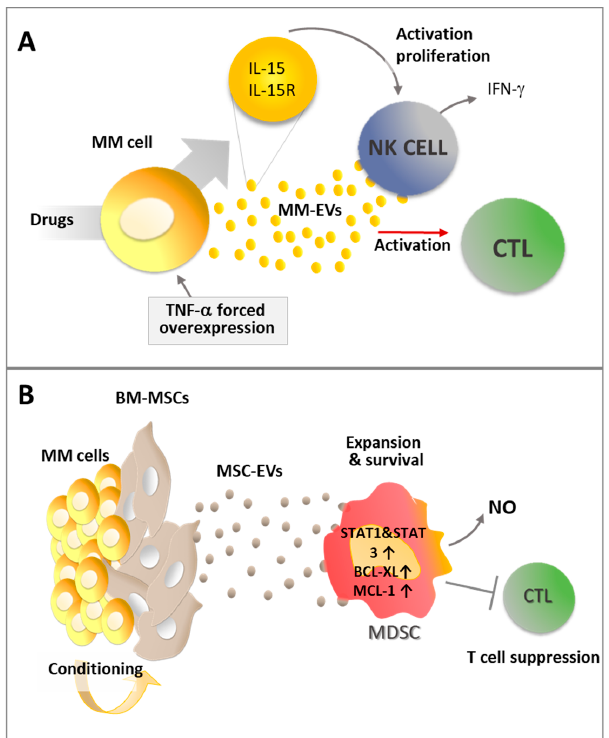
Figure 5. ( A ) MM-EV immune activating effect may be increased by pharmacological treatments and inflammatory stimuli; and ( B ) MM cells may condition BM-MSCs to release immune suppressive EVs that enhance MDSC activity and promote CD8 + cytotoxic T lymphocyte (CTL) suppression. Details in the text.